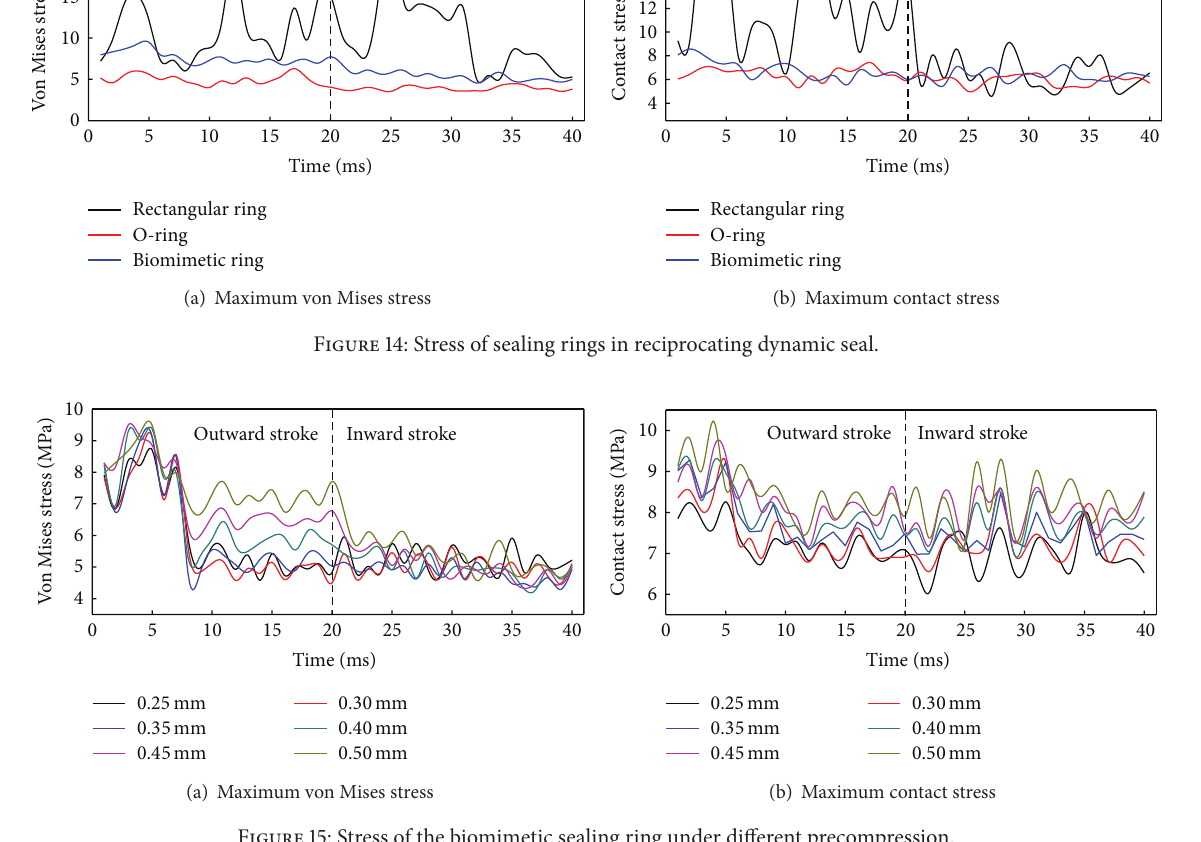
Figure 15: Stress of the biomimetic sealing ring under different